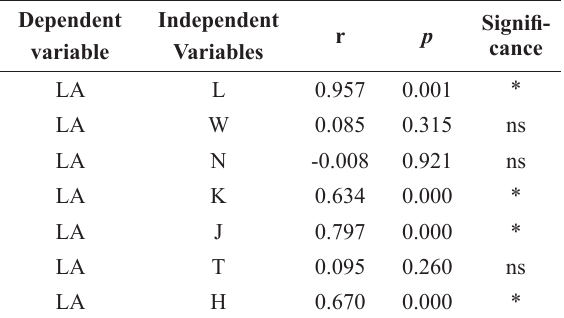
Correlation between the leaf area (LA) and length (L) of the central lobe width (W) of the central lobe, the number (N) of lobes and product length and width (K), length and number of lobules (J), width and number of lobes (T), length, width and number of lobes (H) in cassava leaves, cultivar IAC 576-70, at 80 days after planting in the region of Botucatu, SP, Brazil.